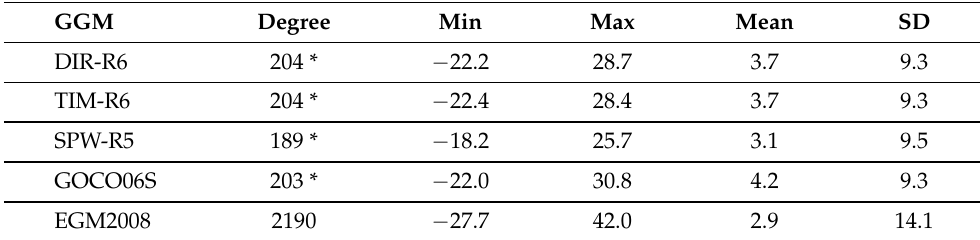
Figure 6. Standard deviation (colored bars) of the residual geoid heights of spectrally enhanced GOCE models at optimum expansion degree and their mean values (black bars). Table 2. Statistics of the residual geoid heights of best performing spectrally enhanced GOCE models at optimum expansion degree [unit: